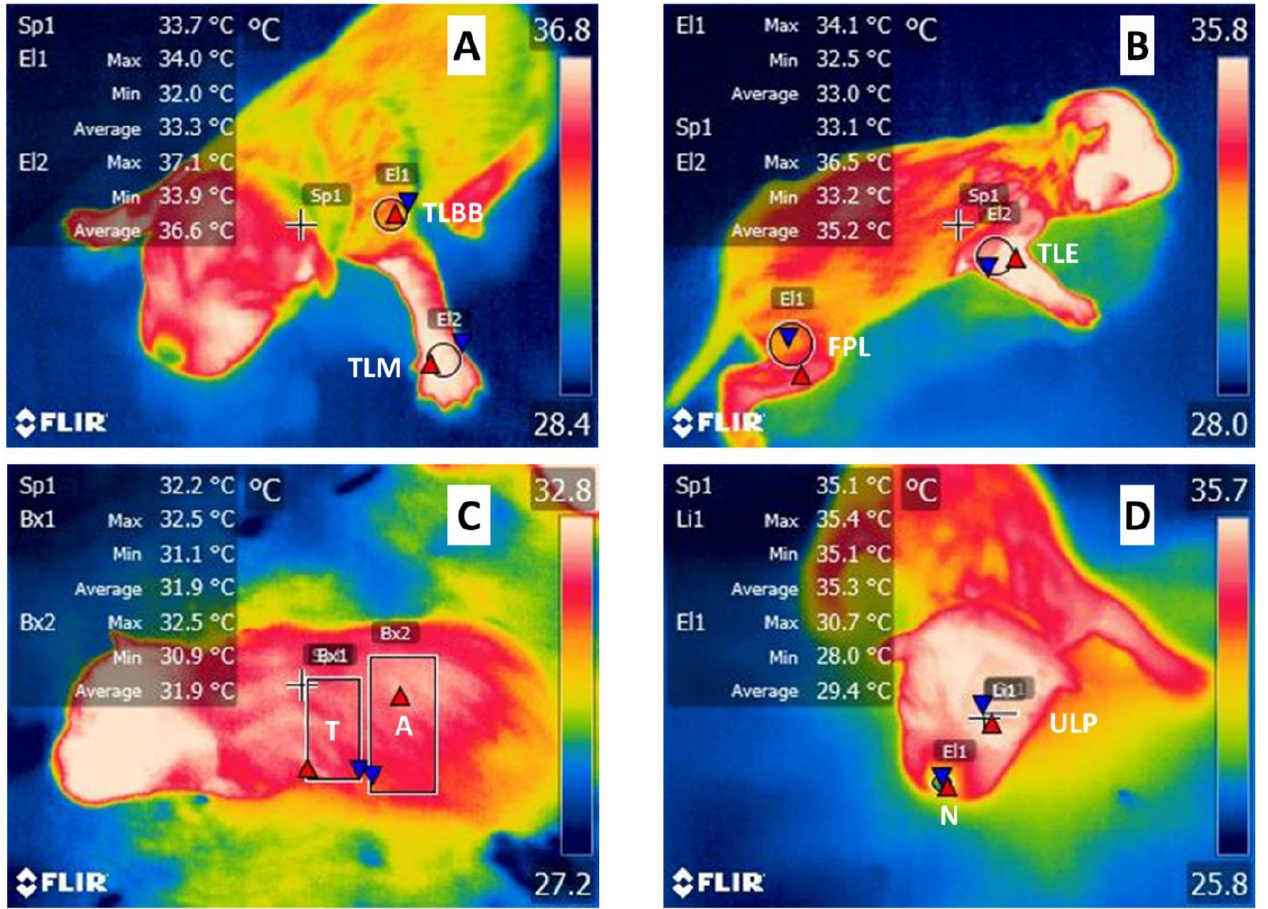
Figure 1. Thermal windows in newborn puppies. ( A ) Thoracic limb brachial biceps (TLBB) and thoracic limb metacarpals (TLM) windows were obtained by placing circular figures from the area where the armpit begins to half the width of the thoracic limb and in the joint formed by the metacarpals covering the area from medial to lateral end, respectively. ( B ) Thoracic limb elbow (TLE) and femoral pelvic limb (FPL) windows were obtained by placing circular figures in the elbow area covering the vertex formed by the humerus-radio-ulnar joint and in the space bounded by the edge of the pelvic limb in the biceps femoris region, respectively. ( C ) Thoracic (T) window was made with rectangular figures delimited by the axillary area, the area of the last rib, and from the region of the spinal vertebrae and to the ventral part of the abdominal region (A) window was delimited by two millimeters after the last rib, to the inguinal area, and from the region of the spinal vertebrae and to the ventral part of the abdomen. ( D ) Nasal (N) and upper left palpebral (ULP) windows were made with circular figures delimited by the edges of the nasal mucosa and at the area of the edge of the left upper eyelid, respectively. Sp1: Spot 1; El1: Ellipse 1; El2: Ellipse 2; Bx1: Box 1; Bx2: Box 2; Li1: Line 1; red triangles maximum temperature of that zone; blue triangles minimum temperature of that